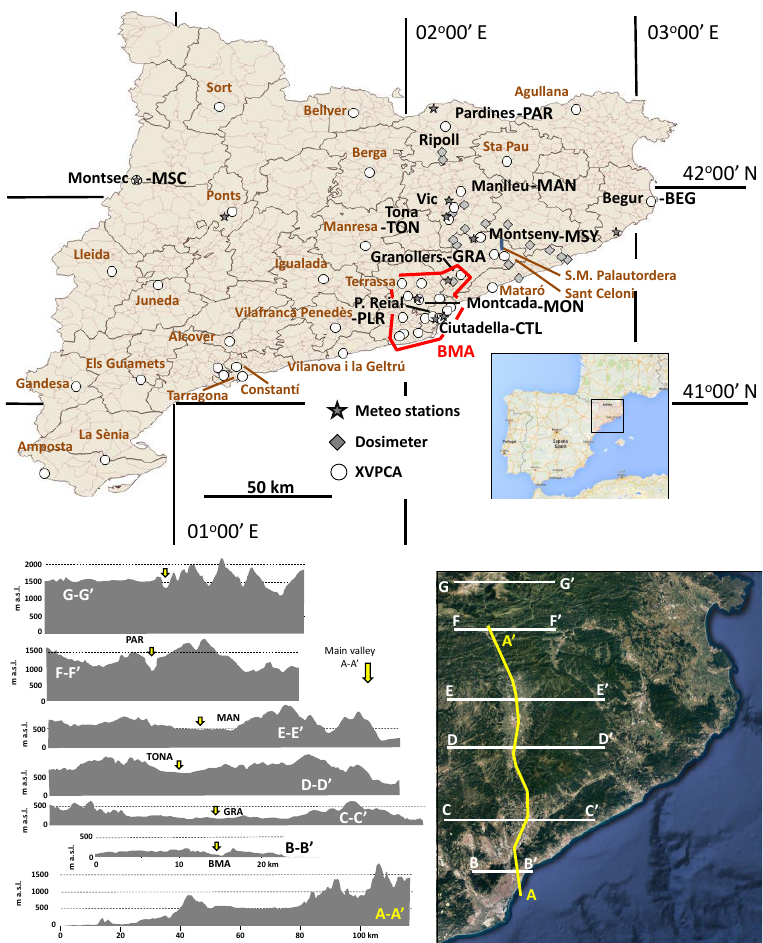
Figure 1. Top: study area and location of monitoring sites (regional air quality monitoring sites XVPCA, dosimeters, meteorological stations and vertical measurements). BMA: Barcelona metropolitan area. Bottom: topographic profiles across the study area, red arrows point to the valleys connecting BMA with the Vic Plain and the pre-Pyrenean